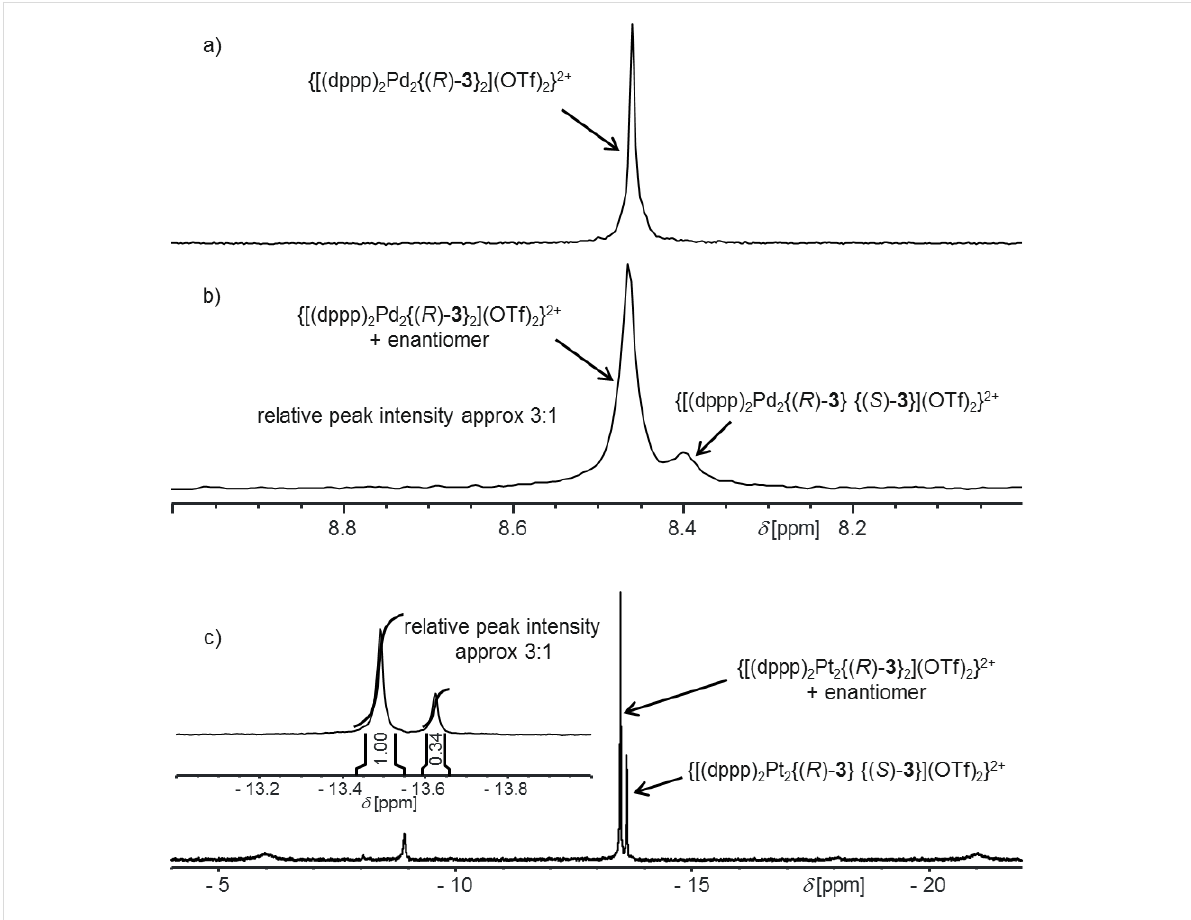
Figure 3: 31 P NMR spectra of a) a 1:1 mixture of [Pd(dppp)]OTf 2 and ( R )- 3 , b) a 1:1 mixture of [Pd(dppp)]OTf 2 and ( rac )- 3 (both recorded at 162.0 MHz in CD 2 Cl 2 /CD 3 CN 3:1 at 293 K), and c) of a 1:1 mixture of [Pt(dppp)]OTf 2 and ( rac )- 3 (202.5 MHz, in CD 2 Cl 2 at 298